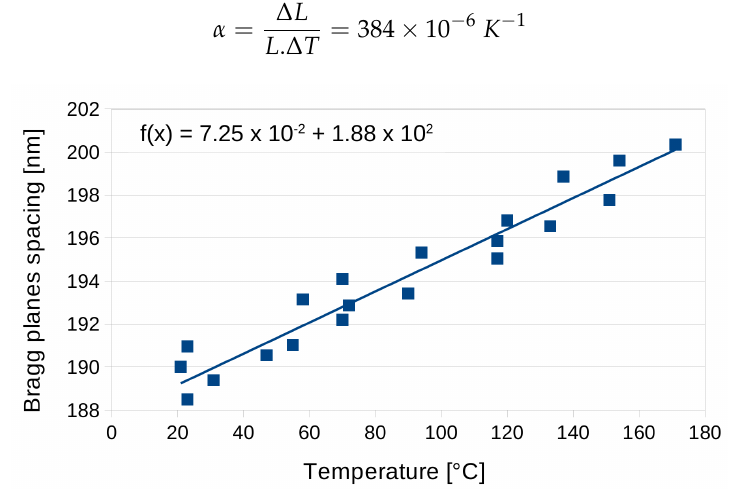
Figure 10. Bragg planes spacing for the Bayfol ® HX200 reflection hologram depending on temperature for 1.5 temperature